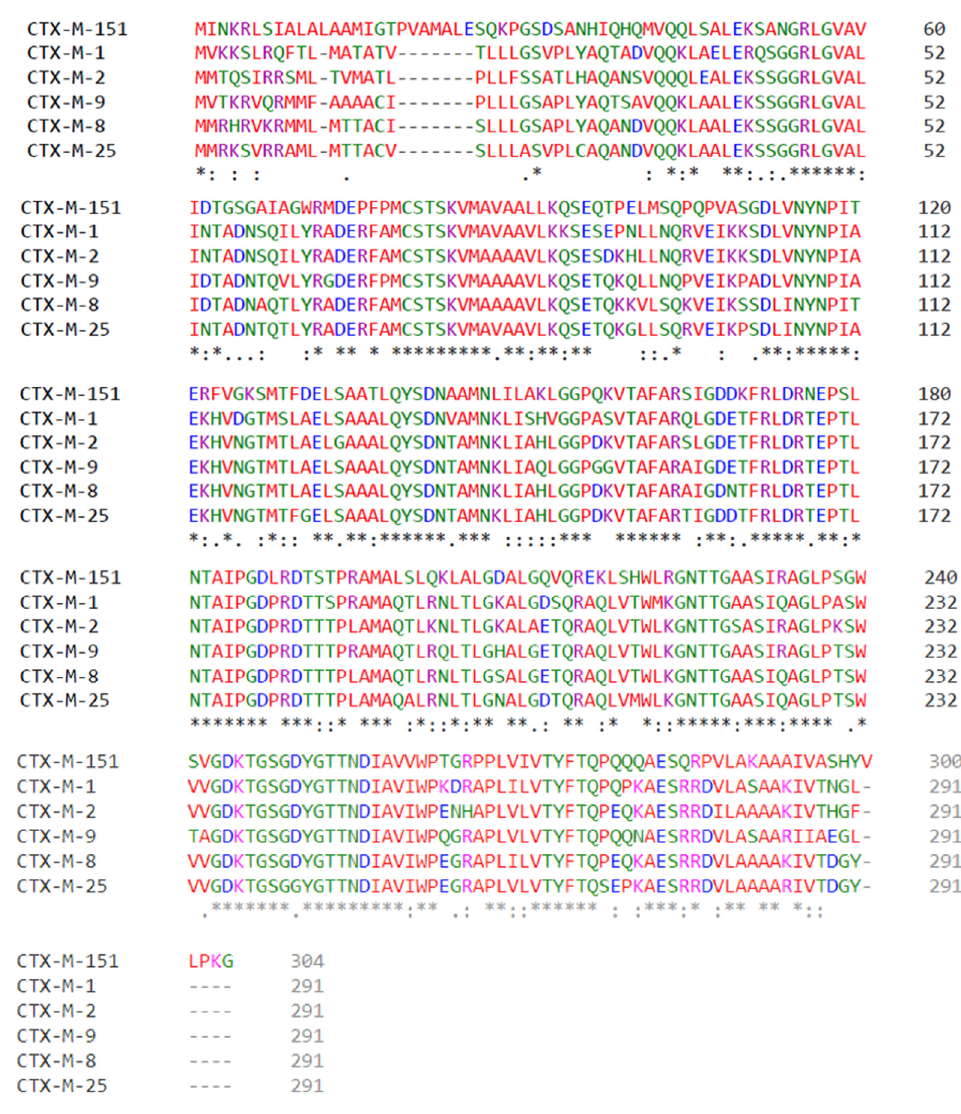
Figure 2. Amino acid multiple alignments. Hydrophobic amino acids are represented in red (A, I, L, M, F, W, V, P). Polar amino acids are represented in green (N, Q, S, T, C, G, H, Y). Positively charged amino acids are represented in magenta (K, R). Negatively charged amino acids are represented in blue (D, E). CTX-M-1, CTX-M-2, CTX-M-8, CTX-M-9, and CTX-M-25 have 291 amino acids, while CTX-M-151 has 304 amino acids. “*” represents fully conserved residues, “.” indicates conservation between groups of strongly similar properties and “:” indicates conservation between groups of weakly similar properties.